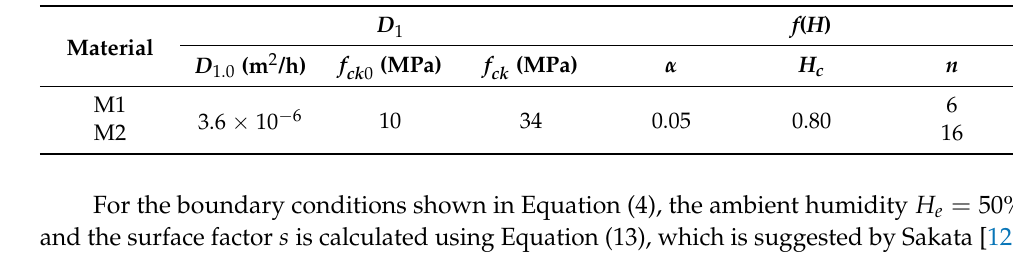
Figure 2. Virtual experiment model and finite element representation: ( a ) virtual model and ( b ) finite element representation.